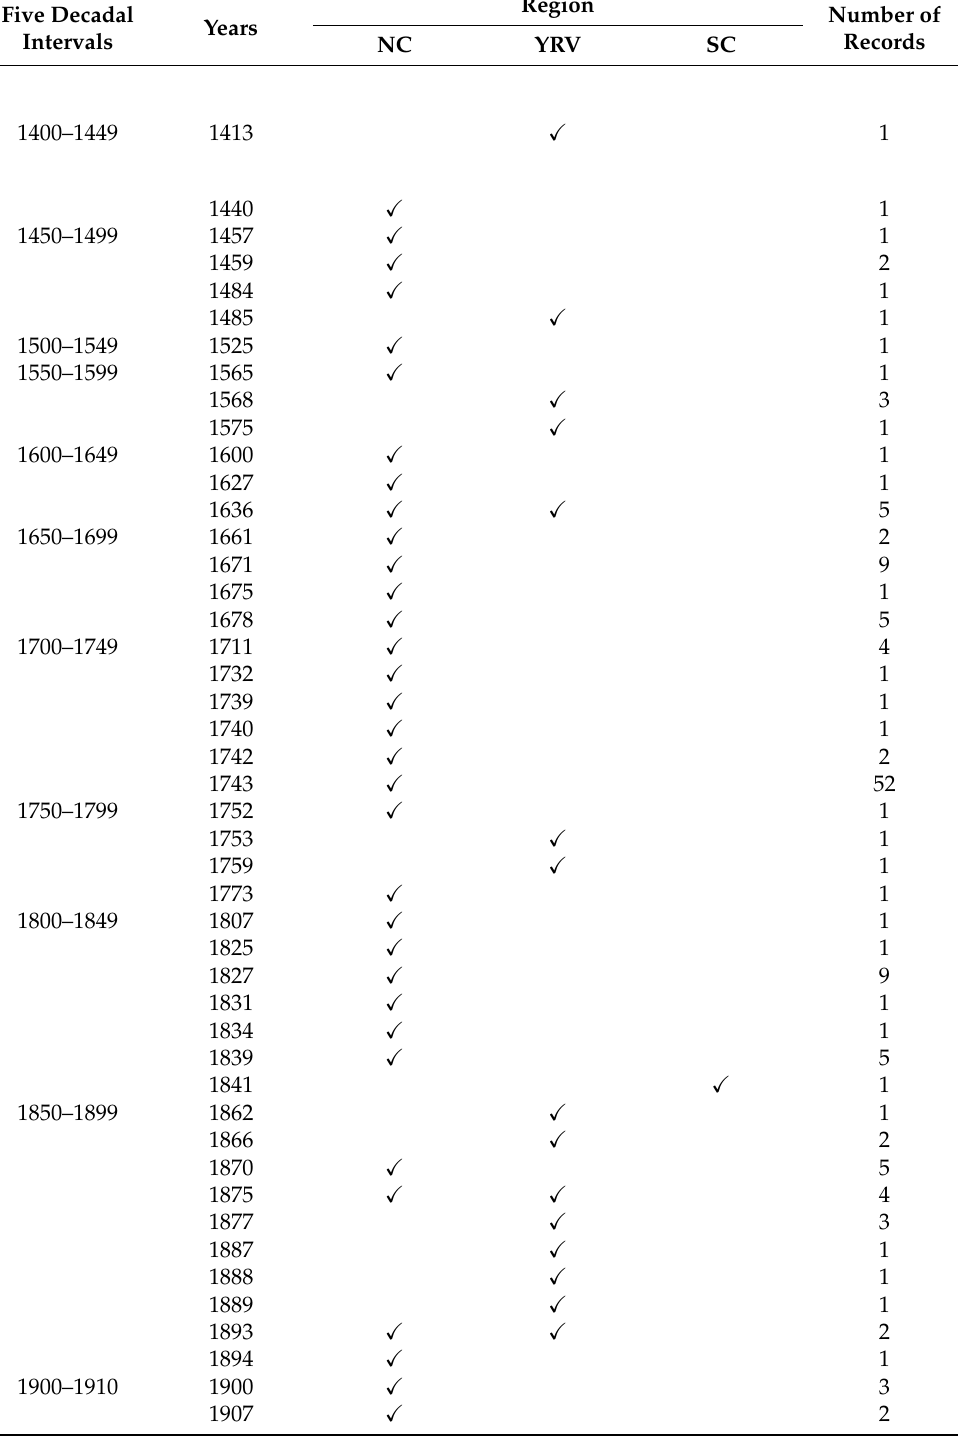
Table 2. Chronological table of warm extremes over three regions in monsoonal